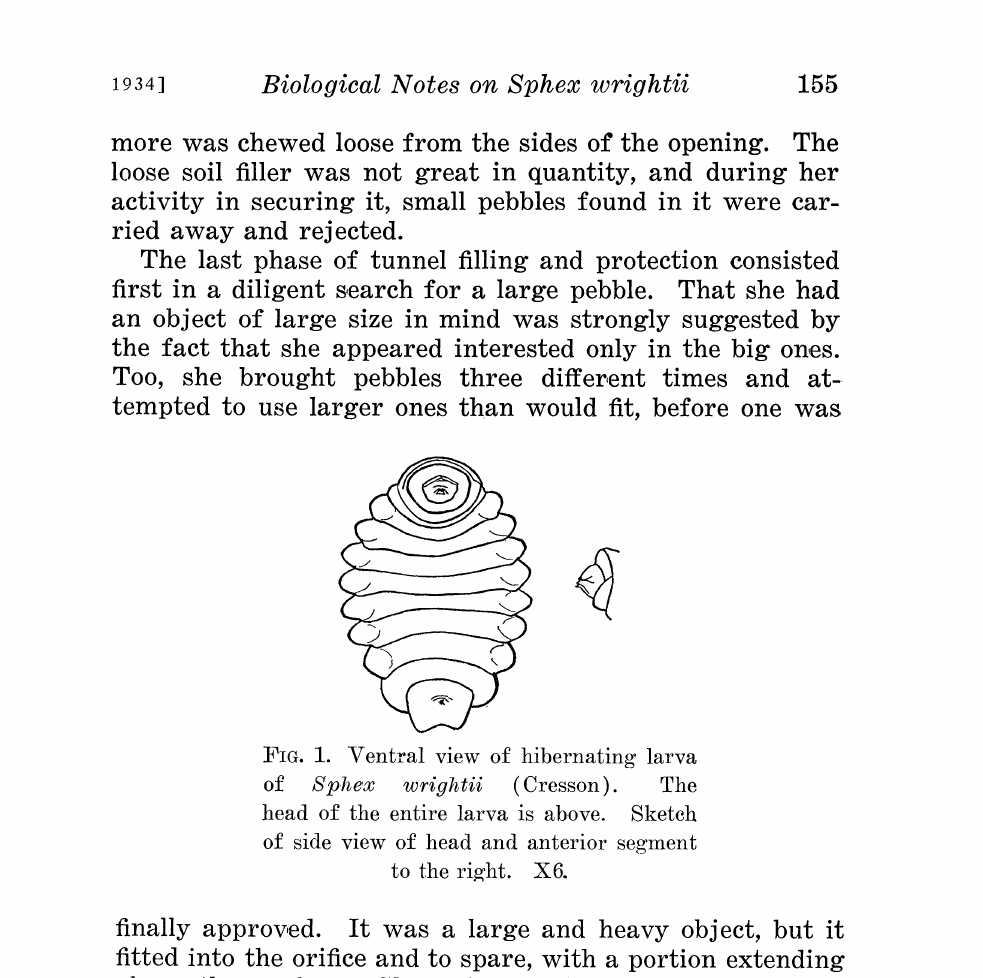
FIG. 1. Ventral view of hibernating larva of Sp.hex vrightii (Cresson). The head of the entire larva is above. Sketch of side view of head and anterior segment to the right.